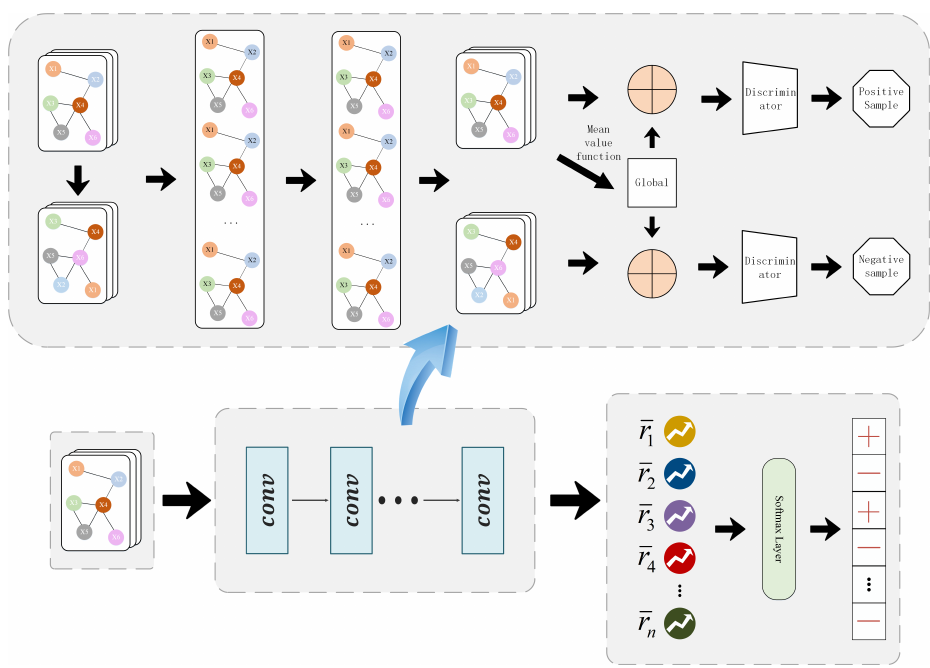
Figure 1. Training process in neural